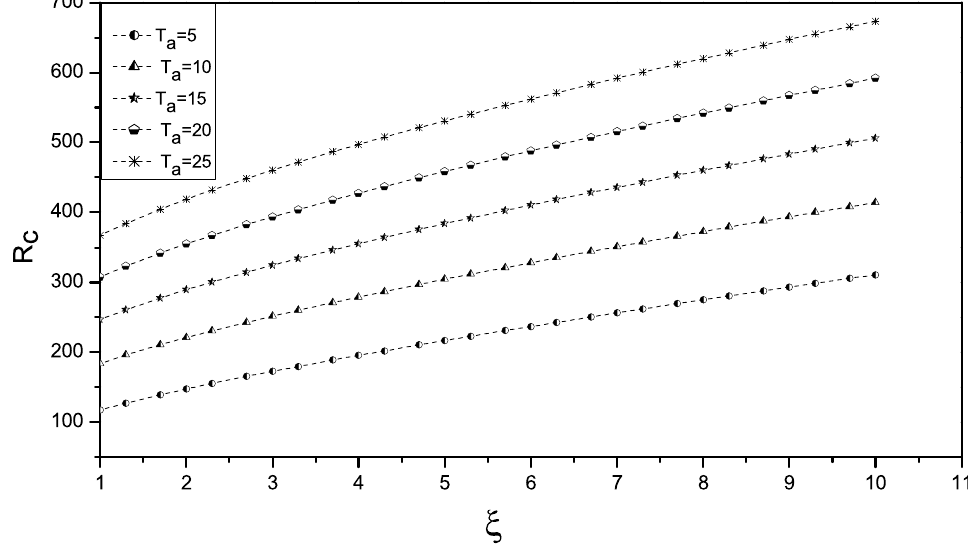
Figure 1. Critical Rayleigh number R c as function of ξ , for ˜ T 2 = 5 increasing to ˜ T 2 = 25.